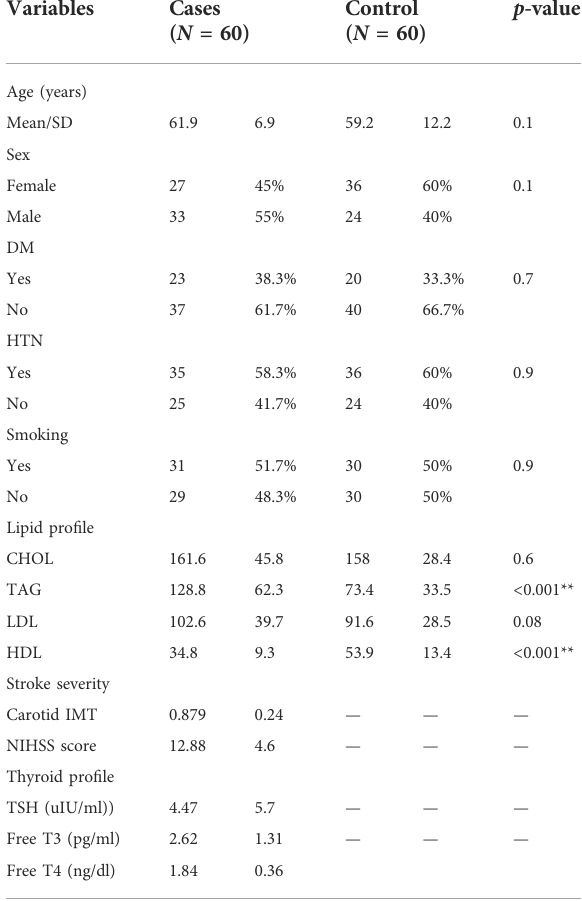
TABLE2Comparisonsofthedemographiccharacteristics ofthestudy